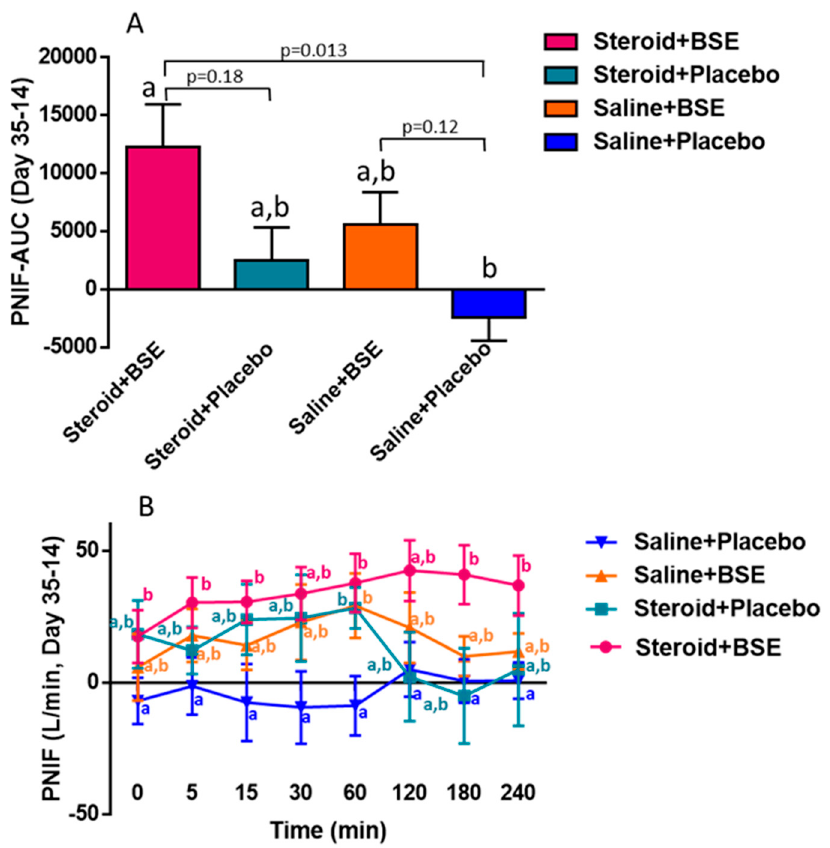
Figure 2. Differences between before intervention (day 14) and completion of intervention (day 35) for PNIF. AUC was calculated for PNIF among the 4 groups, showing a mean of 0.3362 (sd 0.0026) in group 1, 0.1213 (0.0607) in group 2, 0.0636 (0.0485) in group 3 and − 0.0538 (0.0453) in group 4 ( A ). Changes over time are displayed ( B ). Differences in letters indicate statistical significance .